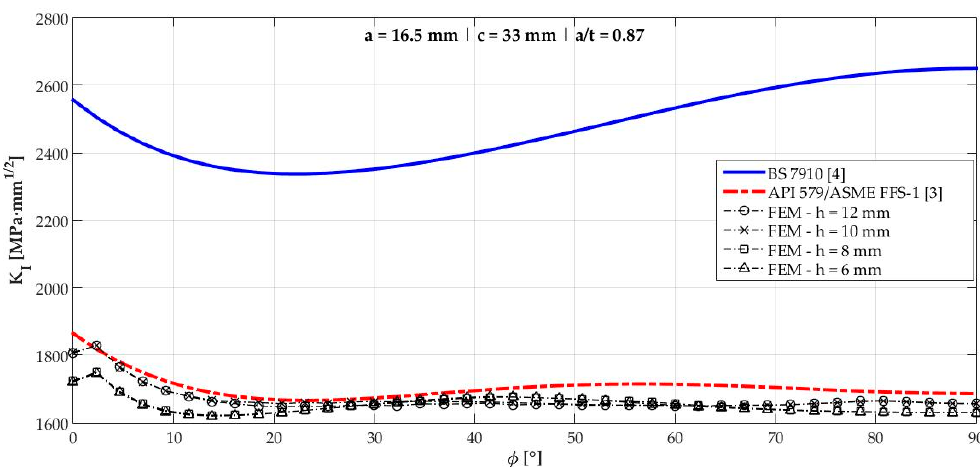
Figure 14. Mode I SIF profiles for crack 9 ( a = 16.5 mm , c = 33 mm , and a/t = 0.87 ).